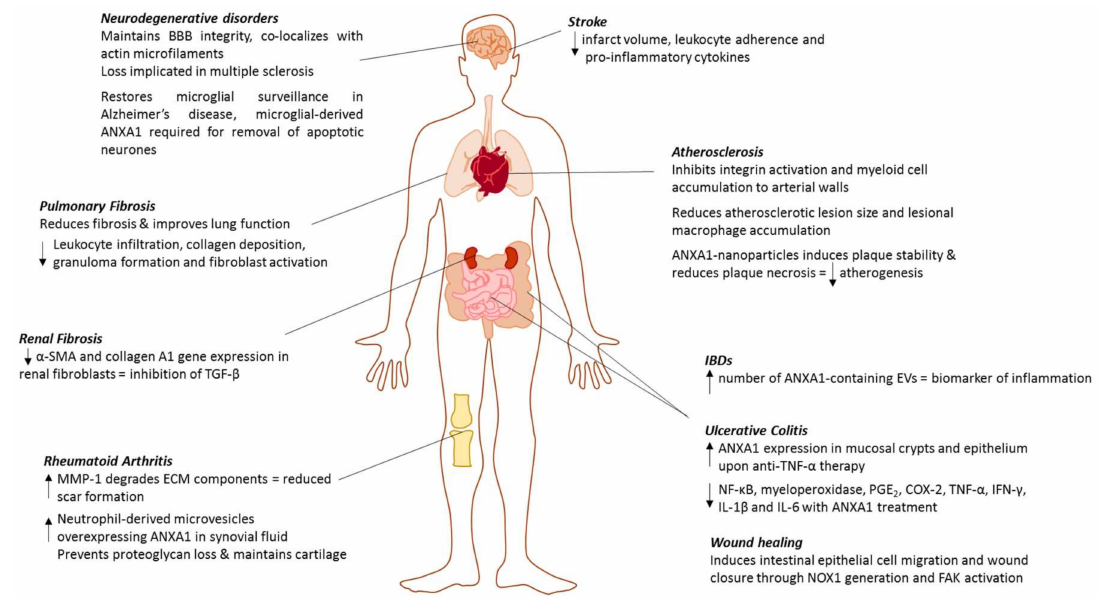
Figure 2. Summary of the involvement and therapeutic potential of ANXA1 in various disease states within the